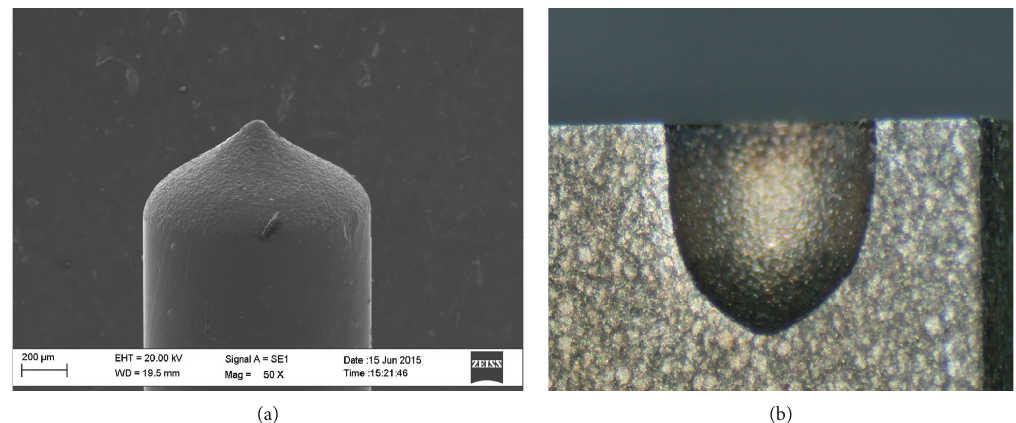
Figure 8: Electrode shape with positive polarity in the 45th minute (no. 3 of Table 1). (a) Electrode with a sharp tip. (b) Cross section of the hole.